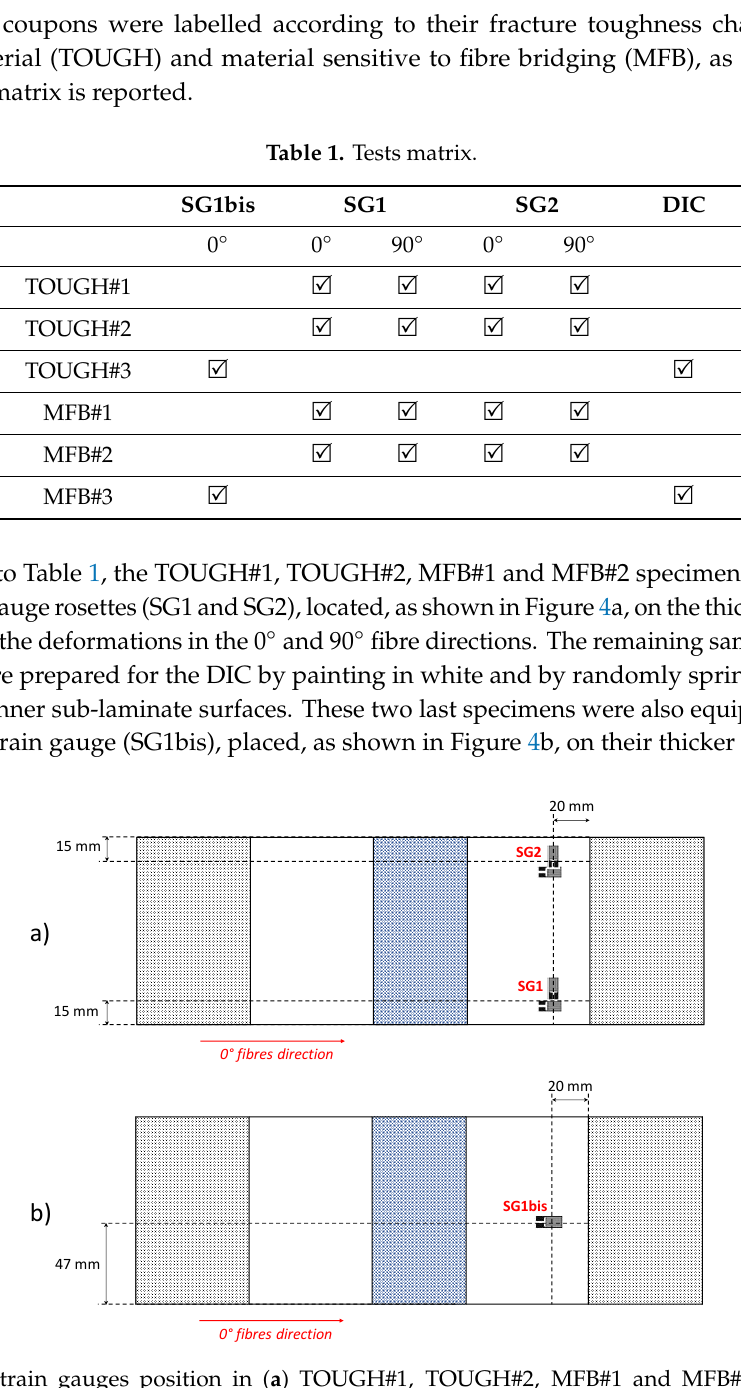
Figure 3. Specimen stacking sequence and delamination position along the thickness.